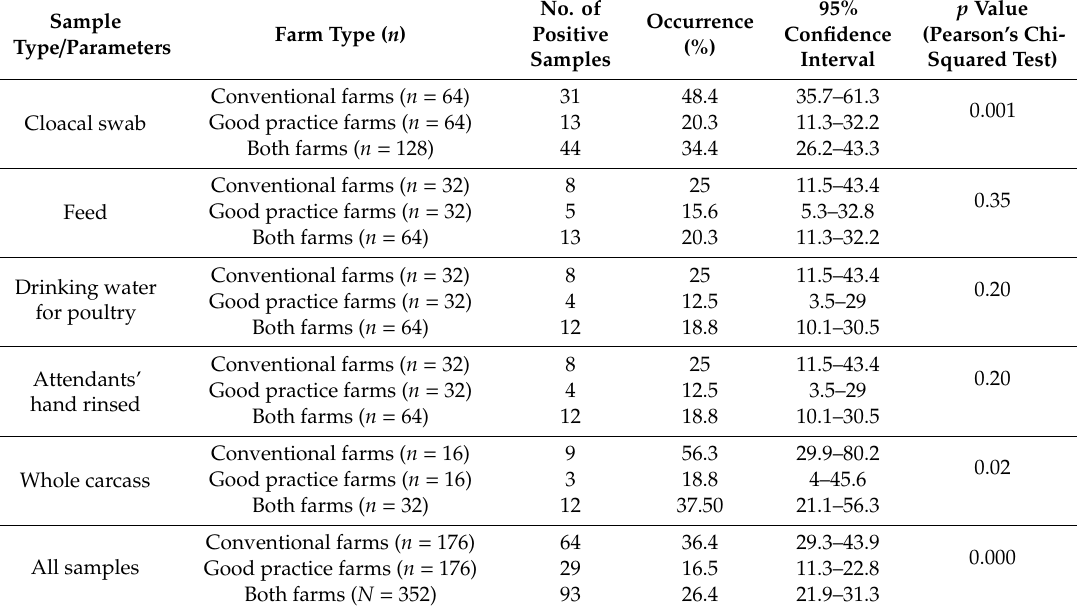
Table 4. Occurrence of Campylobacter spp. in di ff erent types samples among two groups of broiler farms (good practice farms versus conventional